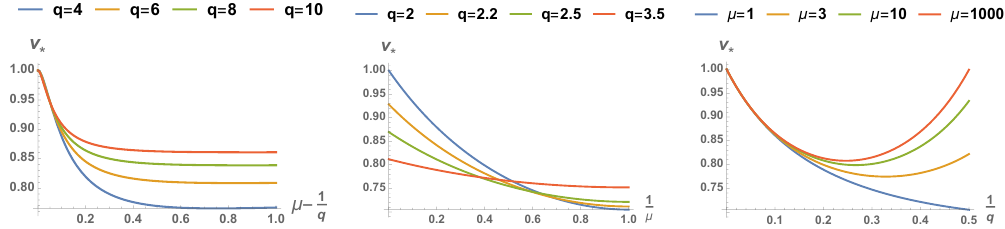
Figure 8 . Left and middle: (cid:22) dependence of the critical velocity in N = (0 ; 2) model with various q . Right: q dependence of the critical velocity at di(cid:11)erent values of (cid:22)